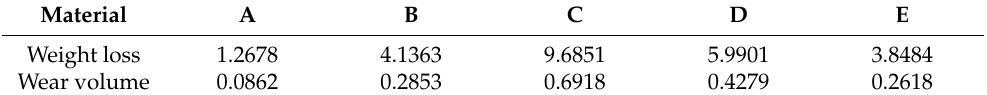
Table 4. Wear losses and wear volume for the indicated grades of Table 1.